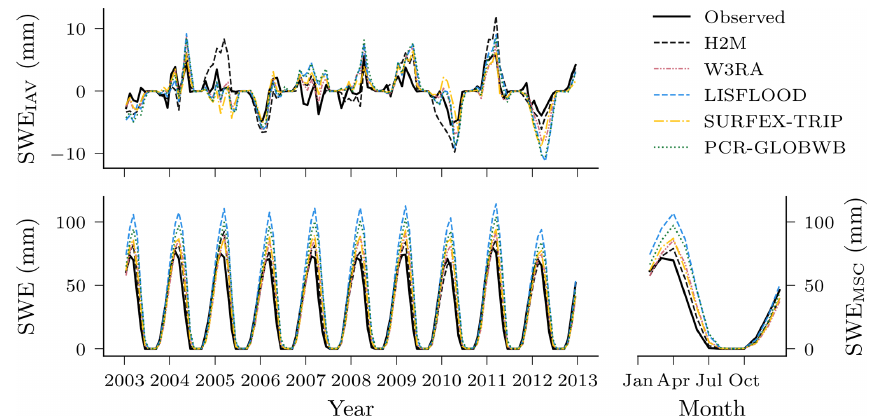
Figure 5. Comparison of the hybrid hydrological model (H2M) and a set of process-based global hydrological models (GHMs) of the snow water equivalent (SWE), its mean seasonal cycle (SWE MSC ), and its interannual variability (SWE IAV ) for the global signal. The time series were aggregated using the cell-size-weighted mean across all grid cells. The regional time series are show in Appendix B, Fig. B2.